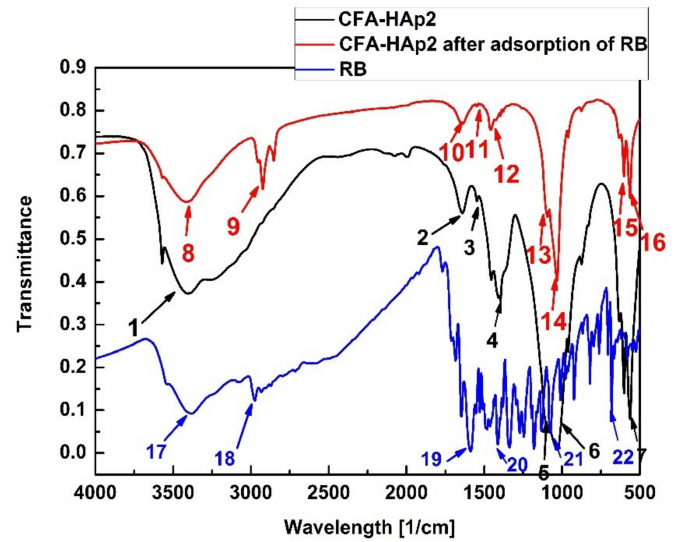
Figure 8. FT-IR spectra of CFA–HAp2 before and after RB adsorption and for RB dye